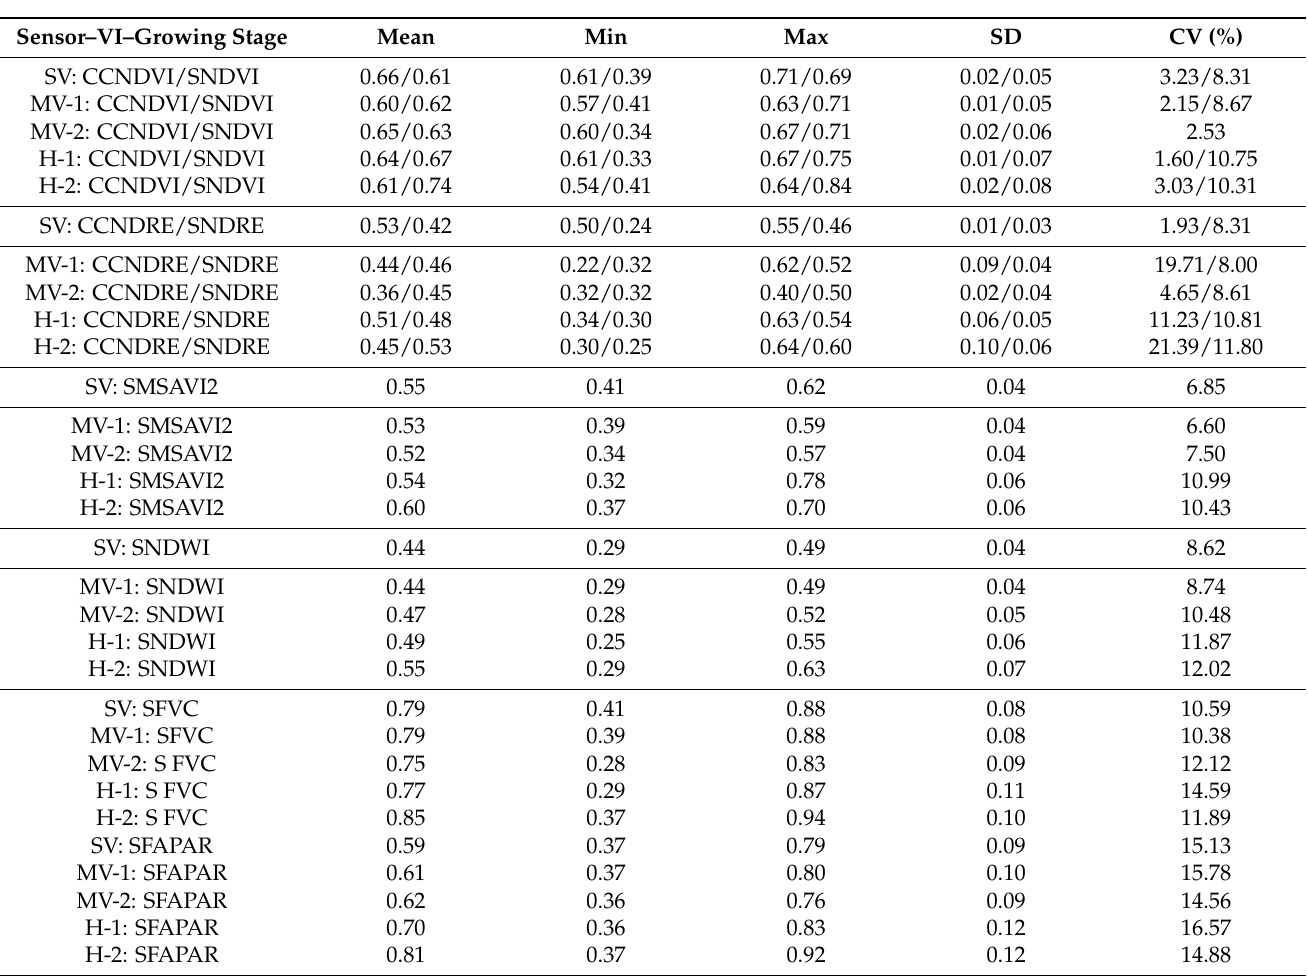
Table 2. Descriptive statistics of the vegetation indices (Vis) and vegetation biophysical variables (VBVs) at the five different crop stages.